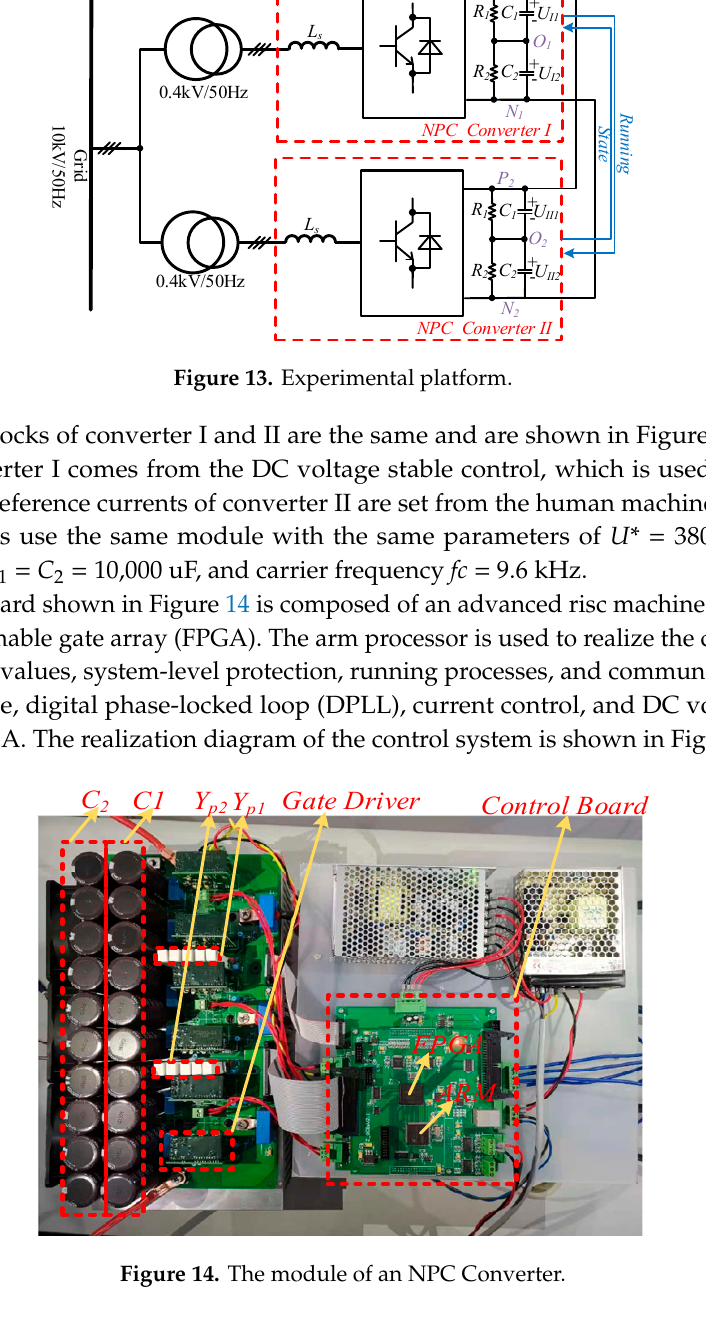
Figure 15. Realization diagram of the control system. Figure 16 shows the waveforms of the system voltage 𝑢 (cid:3028) , output current 𝑖 (cid:3028) of converter II, DC- side up and lower voltages U II1 and U II2 without the DC voltage balancing control. The reference currents are 𝐼 (cid:3031)∗ = 𝐼 (cid:3044)∗ = 50 A . From Figure 16b, it can be seen that there is deviation, and 〈𝑢 (cid:2870) 〉 (cid:2868) = 5 V, which means that the upper loss is smaller than lower loss, ∆ y < 0. u s a ( 100 V / d i v ) i s a /i a ( 50 A / d i v ) ( b ) Figure 16. Waveforms without balancing control. ( a ) Waveforms of 𝑢 (cid:3028) , and 𝑖 (cid:3028) . ( b ) Waveforms of U II1 and U II2.